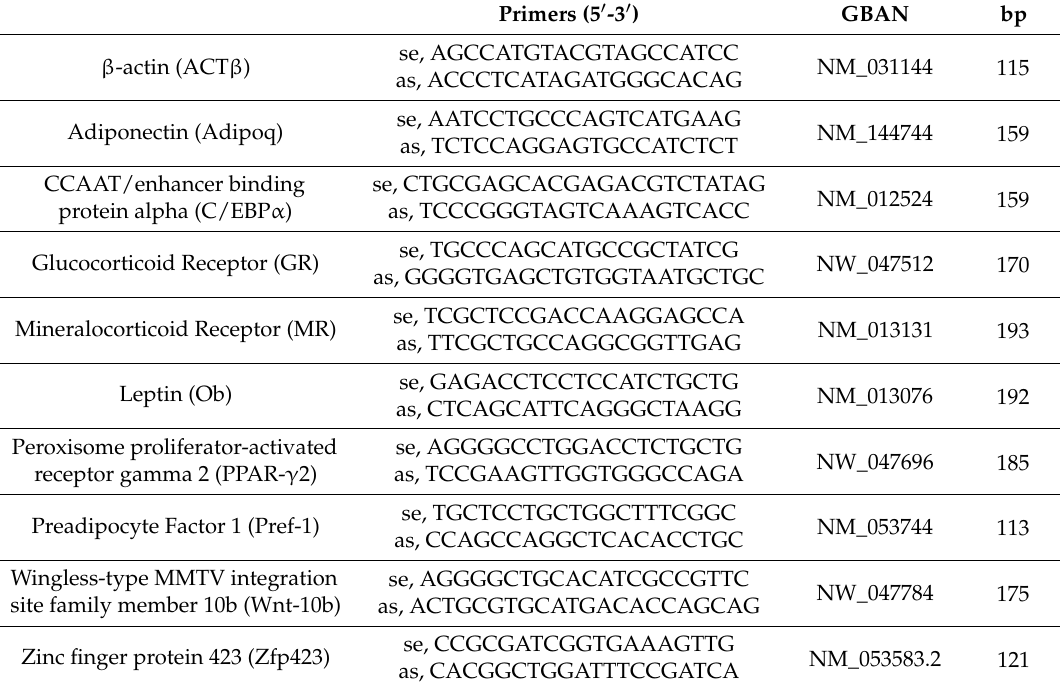
Table 1. Primers used for real-time polymerase chain reaction (PCR)